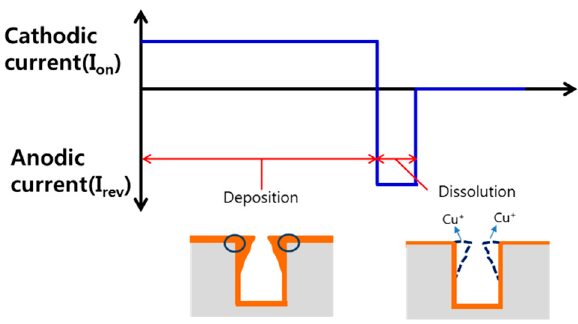
Figure 9. Behavior of on-reverse current condition in electrodeposition.